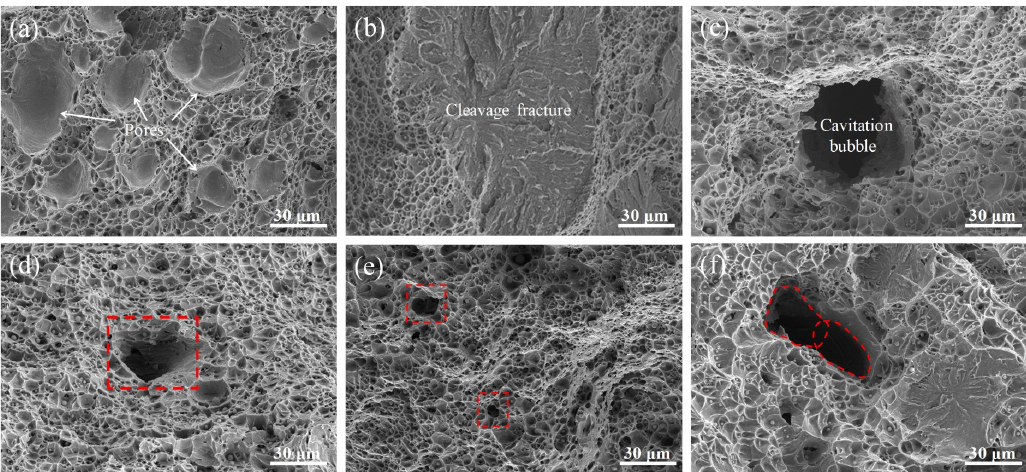
Figure 14. Impact fracture morphology of joints welded at different ultrasonic output power: ( a ) and ( b ) without ultrasonic-assisted, ( c ) 20%, ( d ) 40%, ( e ) 60%, and ( f ) 100%.